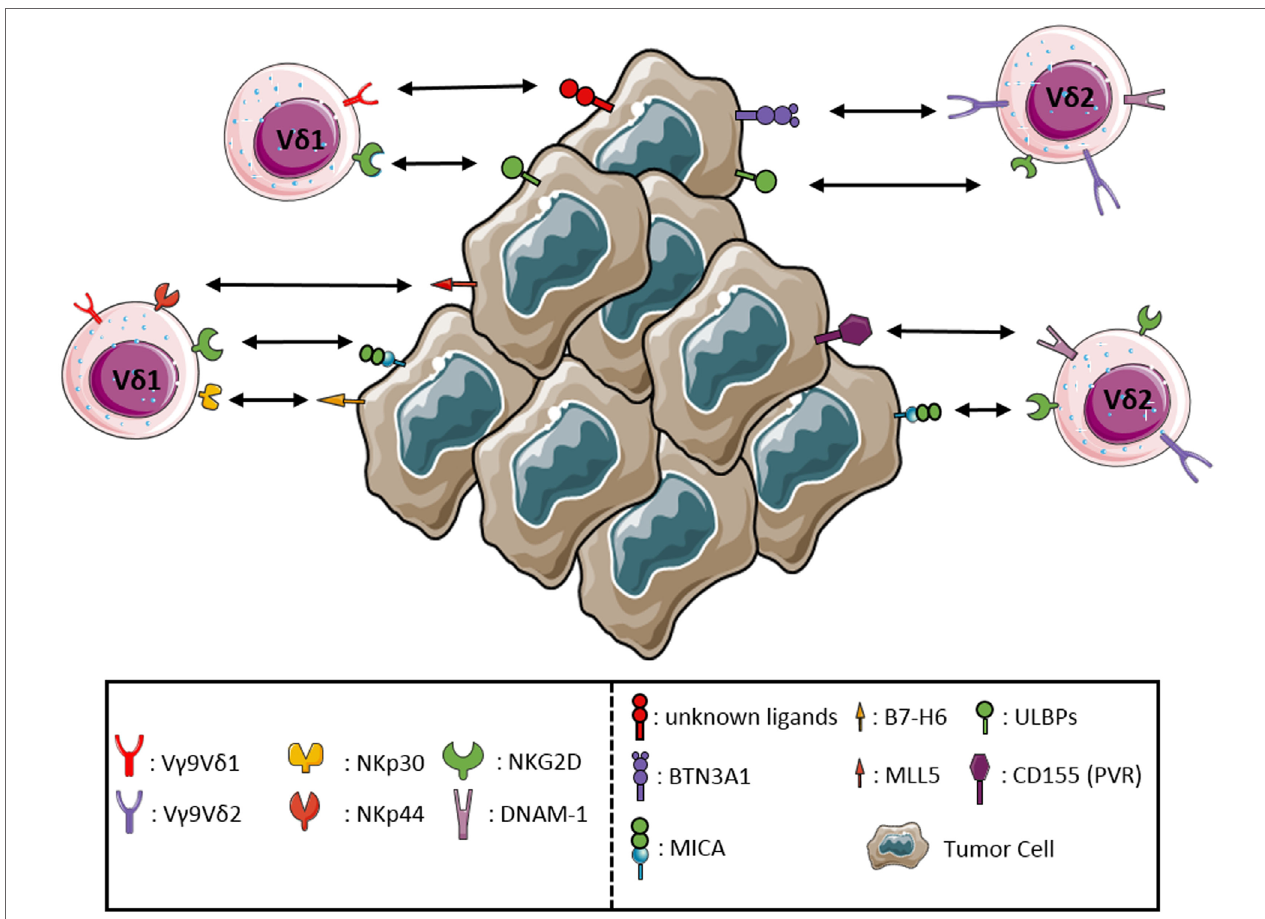
FiGURe 1 | Receptor–ligand interactions between γδ T lymphocytes and tumor cells. The major interactions occurring between the activating receptors expressed by γδ T lymphocytes and the corresponding ligands either de novo expressed or upregulated by tumor cells are represented in